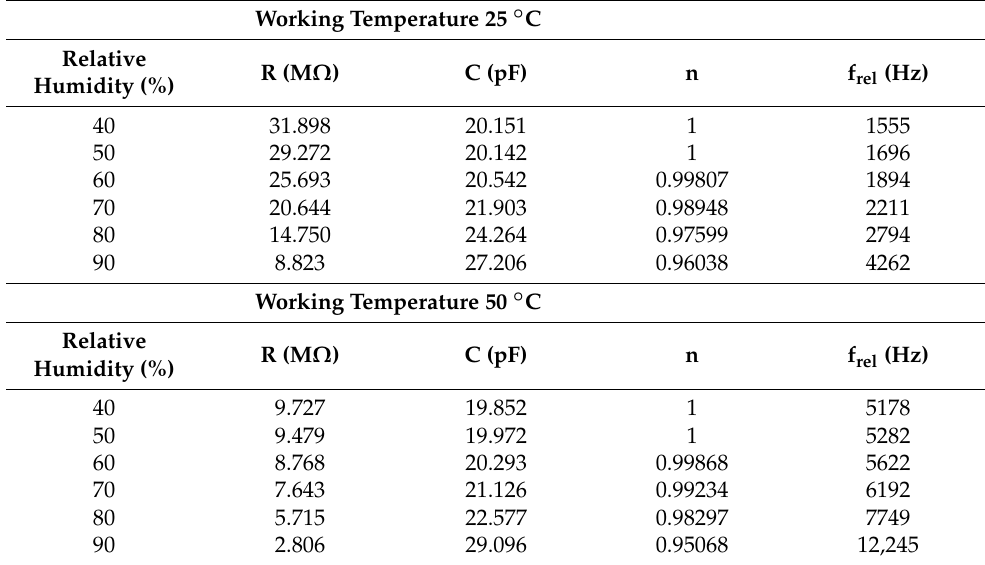
Table 1. Resistance, capacitance and critical exponent calculated from measured complex impedance spectra using the equivalent circuit composed of a parallel resistance and CPE